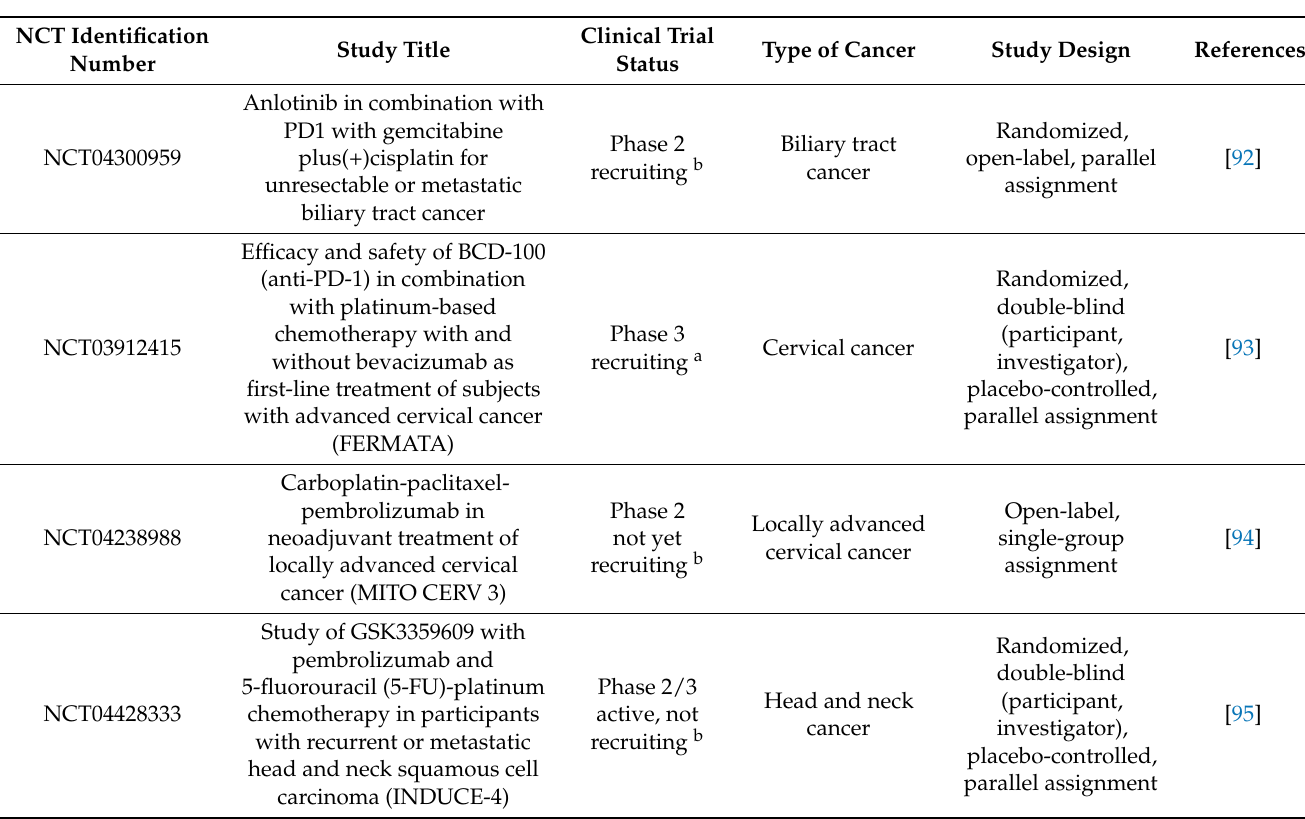
Table 1. Recent and current clinical trials of platinum-based (mainly cisplatin, carboplatin, oxaliplatin) therapy—studies initiated in 2019–2021. This table was compiled from the information available at https://www.clinicaltrials.gov/ (accessed on 25 May